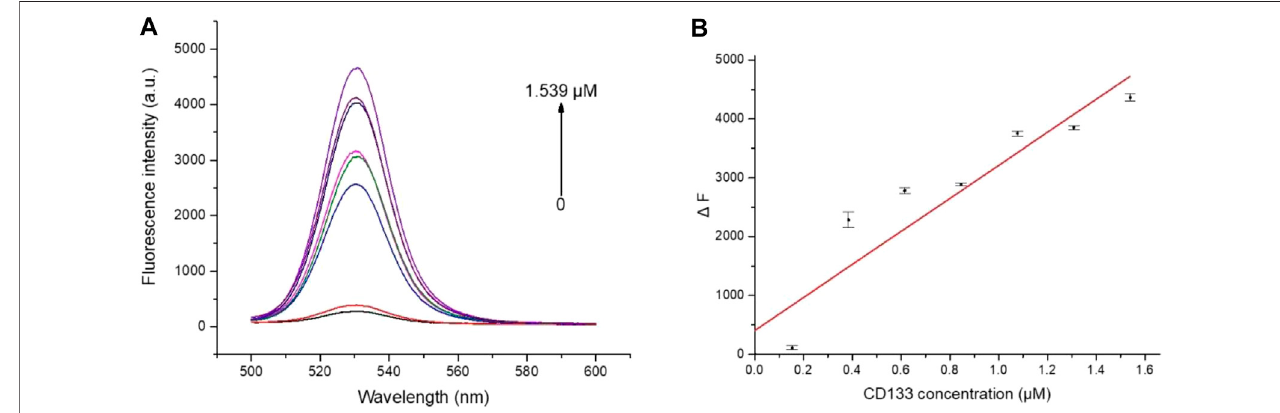
FIGURE 6 | (A) The fl uorescence spectra of the aptamer sensor treated with different concentrations of CD133. (B) The plot of Δ F as a function of CD133 concentration.